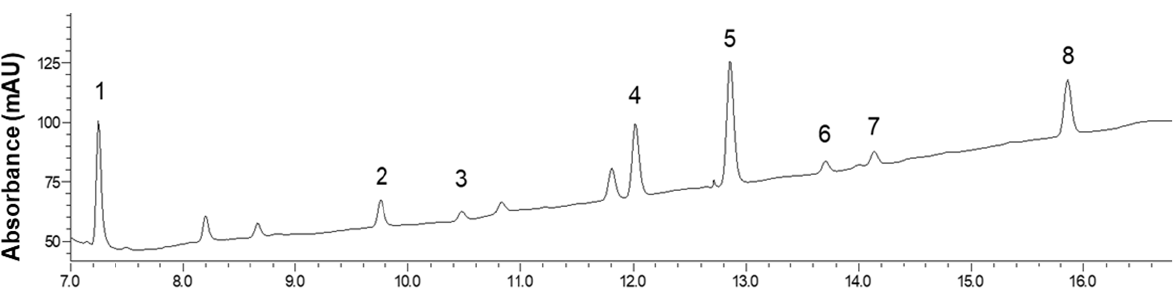
Figure 5. Representative HPLC chromatogram of 100 × CB-treated kale monitored at 229 nm. Peak 1, progoitrin; 2, gluconapin; 3, hydroxyglucobrassicin; 4, glucotropaeolin (internal standard); 5, glucobrassicin; 6, methylglucobrassicin; 7, gluconasturtiin; and 8, neoglucobrassicin. Table 3. Glucosinolates identified in “Red Russian” kale. No RT 1